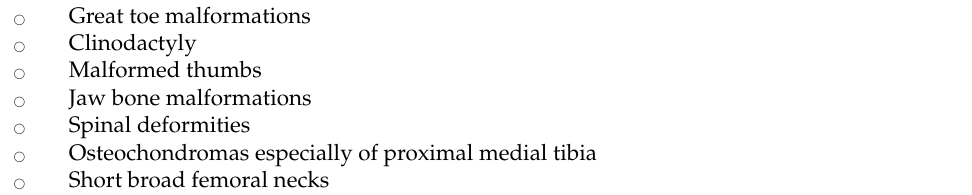
Table 1. Major skeletal anomalies in Fibrodysplasia Ossificans Progressiva (FOP) not caused by heterotopic